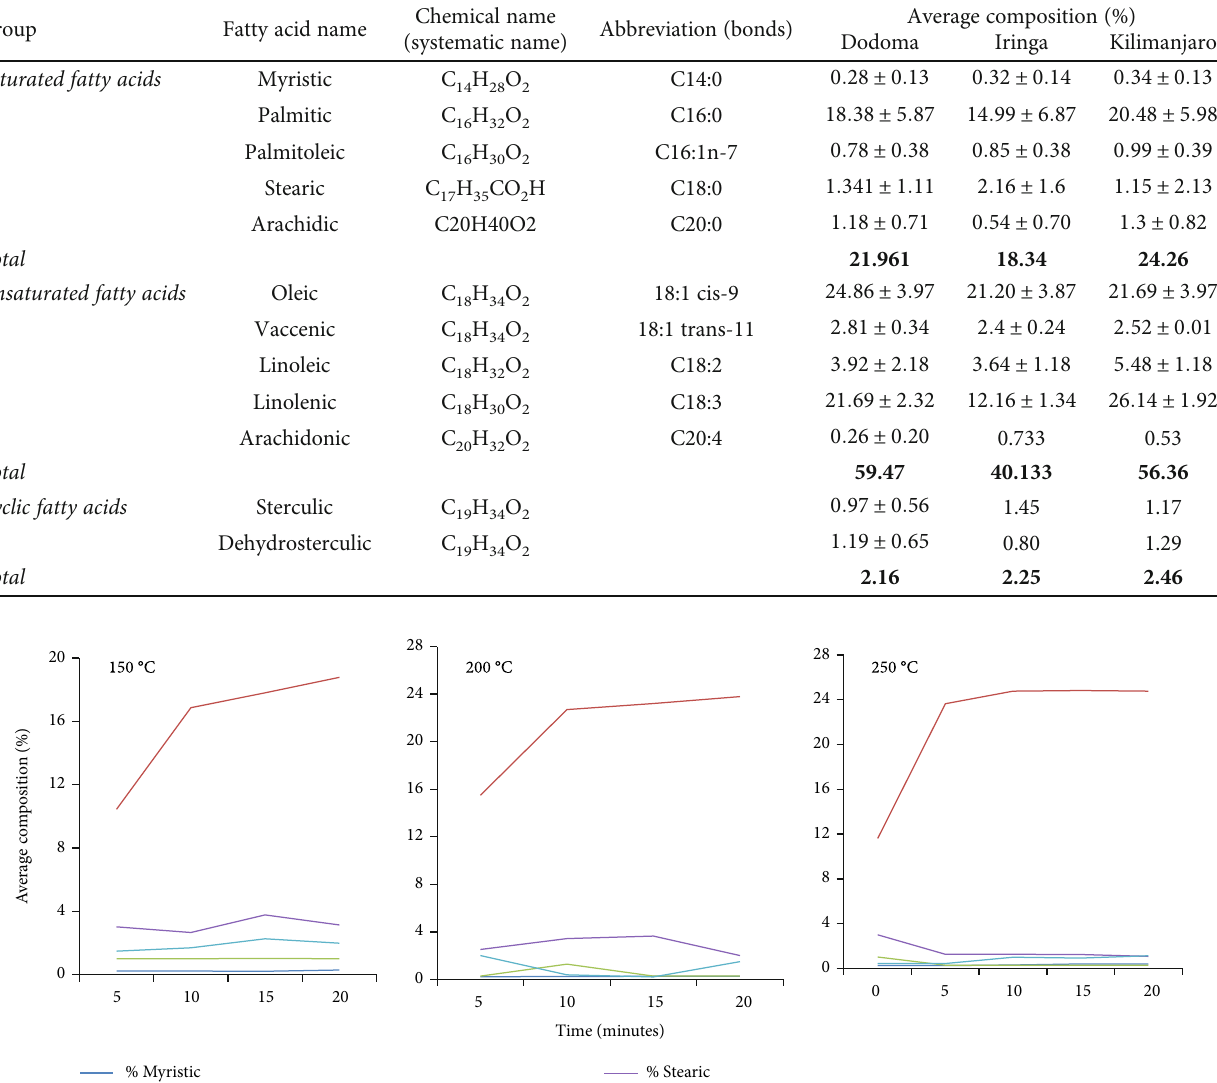
Table 3: Fatty acid levels, expressed as % of total FAs in baobab seed oil.